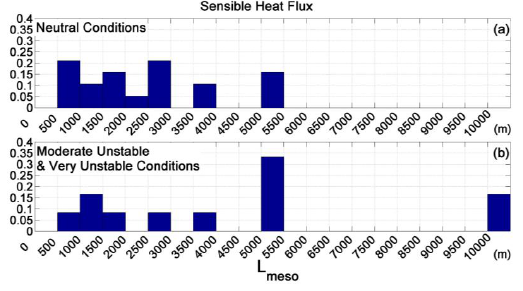
Figure 5. The frequency histograms of the wavelength ( L meso ) at which the sign reversal occurred for sensible heat flux: ( a ) under near neutral conditions and ( b ) under moderately unstable and very unstable conditions. Wavelength interval for frequency histogram is 500 m.